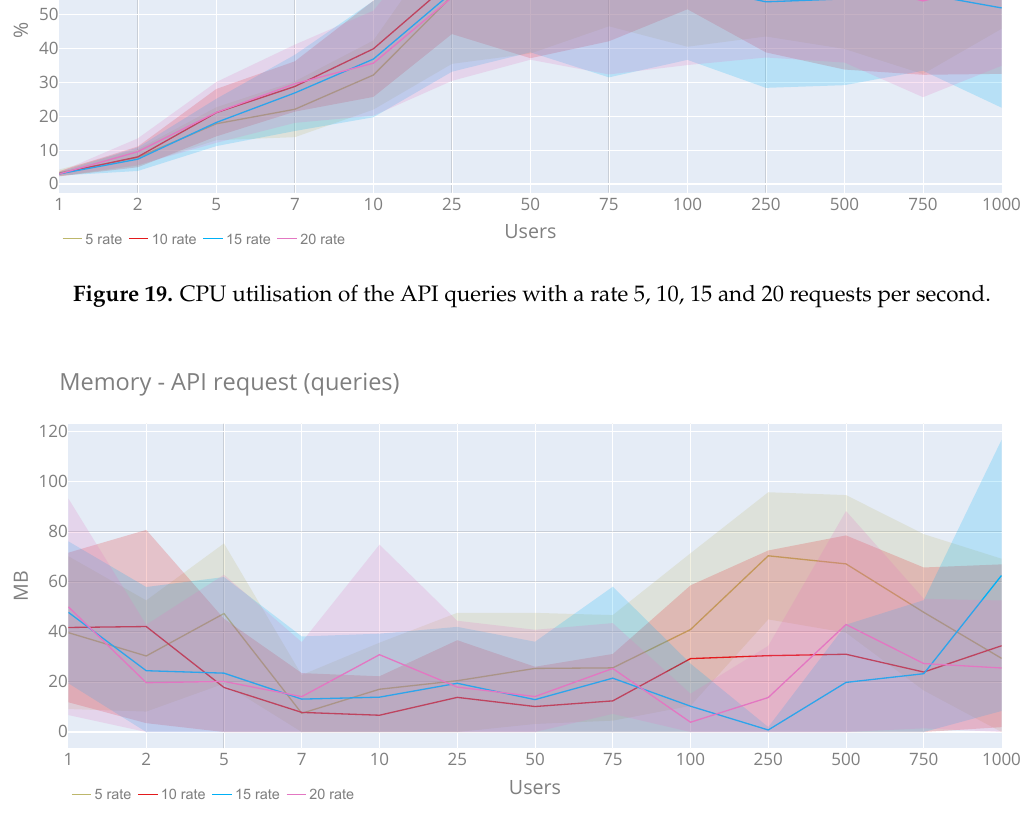
Figure 20. Memory usage of the API queries with a rate of 5, 10, 15 and 20 requests per